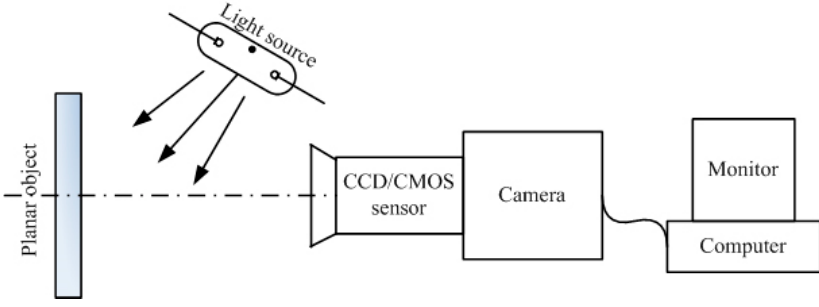
Figure 1. Experimental system for the 2D-DIC. DIC: digital image correlation; CCD: charge-coupled device; and CMOS: complementary metal-oxide-semiconductor.